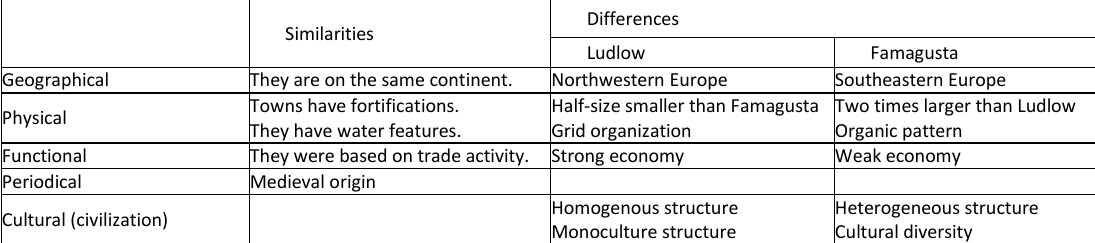
Table 2 Similarities and Differences in Famagusta and Ludlow’s characteristics (Cömert, 2013)